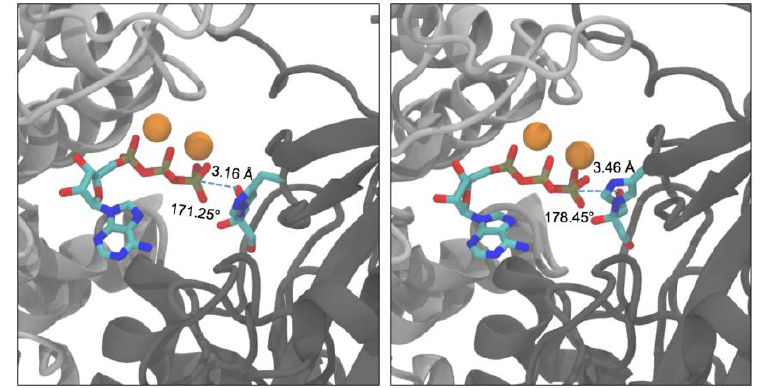
Figure 14. Selected near attack conformations of hTKFC:2DHA:2ATP detected during the molecular dynamics trajectory in the L2 – K1 site. Light gray, L2 domain; dark gray, K1 domain. The images dynamics trajectory in the L2–K1 site. Light gray, L2 domain; dark gray, K1 domain. The images correspond to snapshots 107633 (left) and 108032 (right-hand side). correspond to snapshots 107633 (left) and 108032 (right-hand